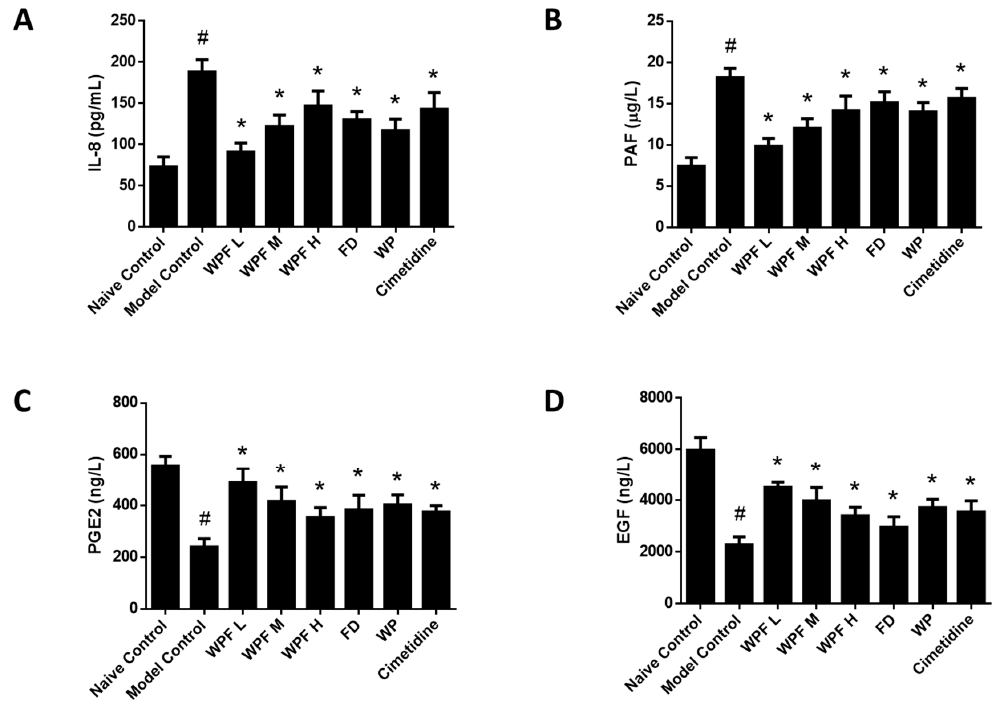
Figure 4. Anti-inflammation and pro-survival effects of WPF. Serum levels of interleukin (IL)-8 ( A ), platelet-activating factor (PAF) ( B ), prostaglandin E-2 (PGE2) ( C ), and epidermal growth factor (EGF) ( D ) were determined by using commercially available enzyme-linked immunosorbent assay (ELISA) kits. Data are presented as mean ± SD. N = 10. # p < 0.05 vs. naïve control; * p < 0.05 vs. model control. WPF L: Low dose of WPF; WPF M: Medium dose of WPF; WPF H: High dose of WPF; FD: Fucoidan; WP: Wheat peptides.